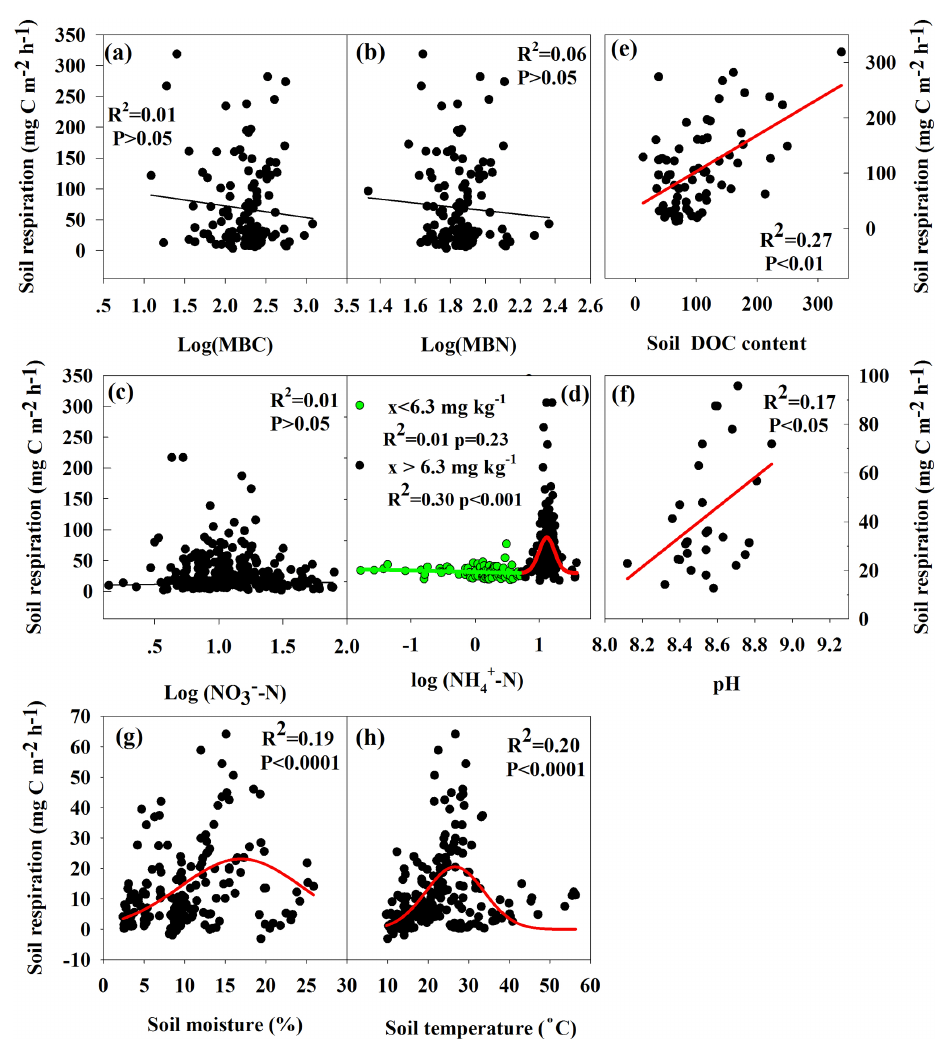
Figure 4. The relationship of soil respiration with microbial biomass carbon (MBC, a ); microbial biomass carbon (MBN, b ); soil NO 3 -N (c) ; NH + -N content ( x , d ); soil dissolved organic carbon (DOC, e ); pH (f) ; soil moisture (g) and soil temperature (h) 4